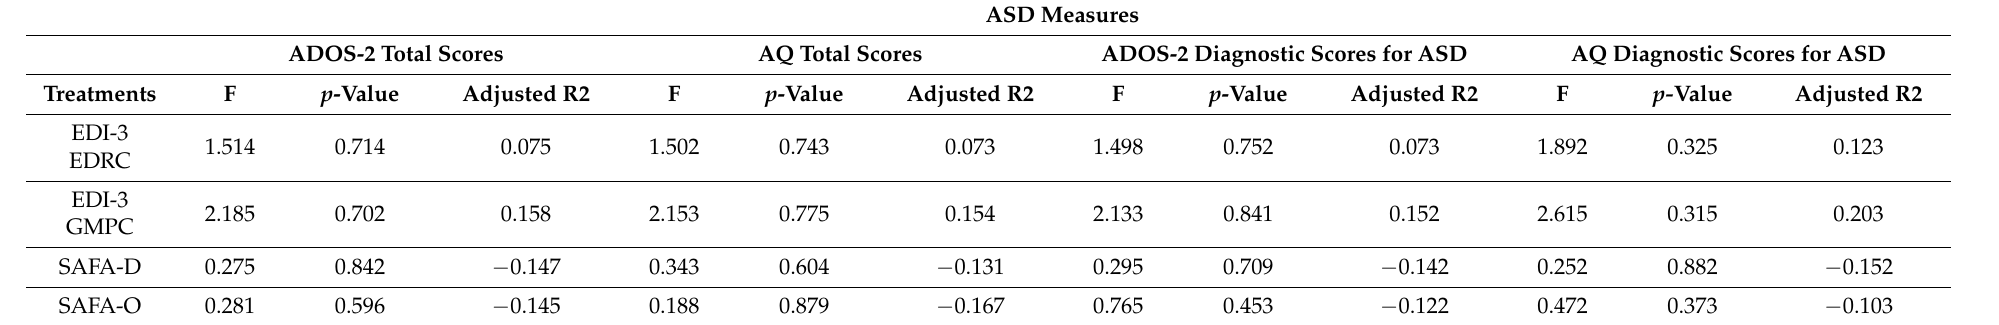
Table 4. ASD traits and psychopathological